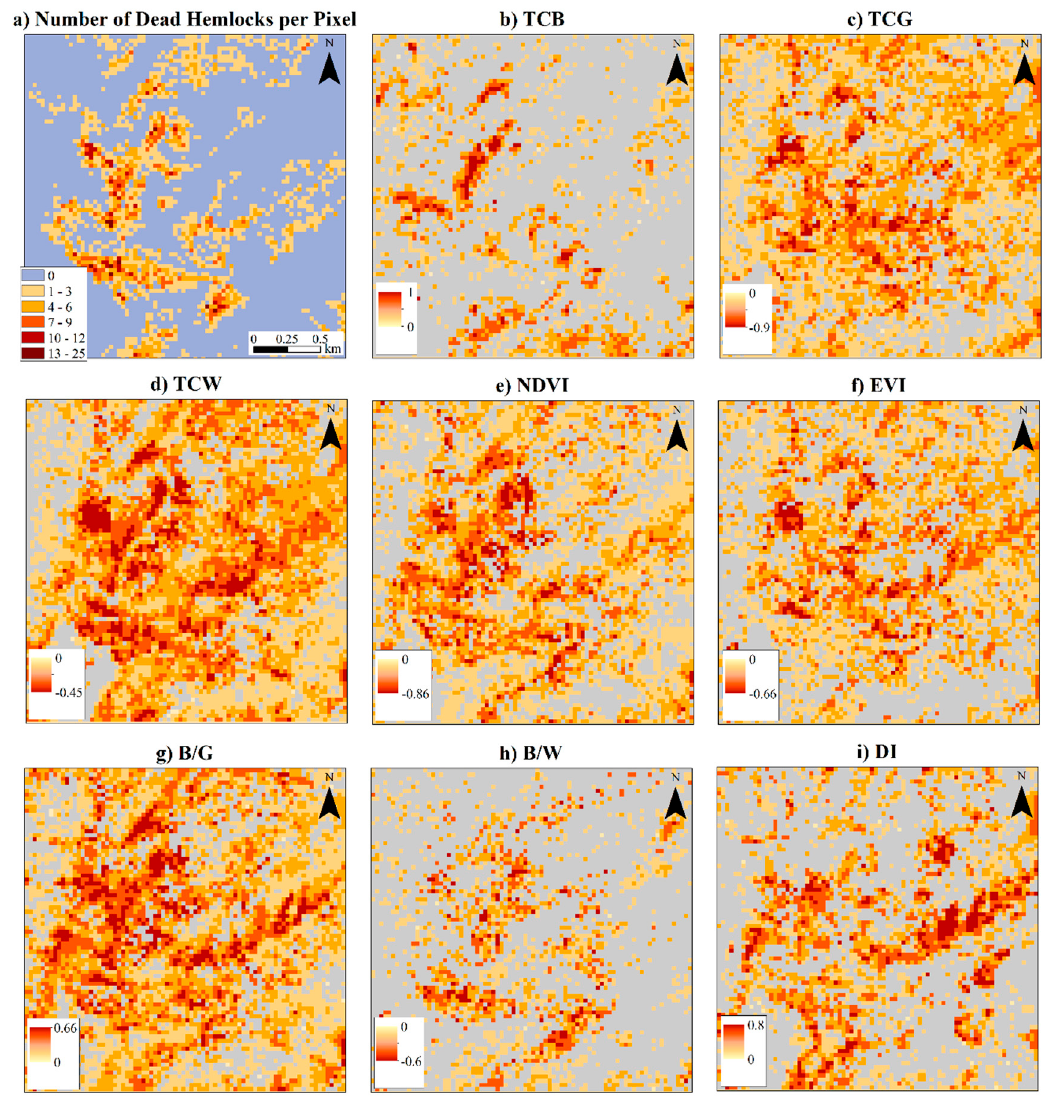
Figure 8. ( a ) Number of dead hemlocks digitized from the high-resolution aerial photos, and maximum disturbance magnitudes within a sub-region 1 (Figure 1), estimated from eight spectral indices: ( b ) TCB, ( c ) TCG, ( d ) TCW, ( e ) NDVI, ( f ) EVI, ( g ) B / G, ( h ) B / W, and ( i ) DI (Table 1). Grey pixels are the pixels with no significant changes from the pre-disturbance condition.